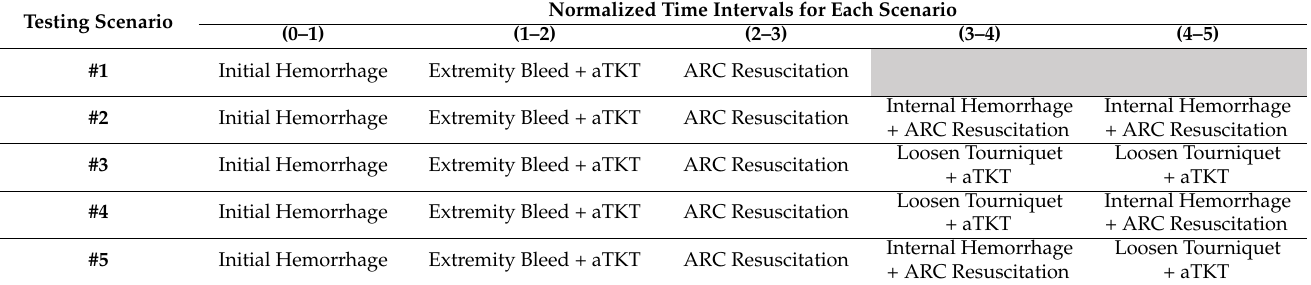
Table 2. Experimental Design for Evaluating SACM. Scenarios or case studies for demonstrating the utility of having SACM controlling multiple autonomous system sub-units. Five scenarios in total were evaluated with different internal or extremity hemorrhages, as shown. Triplicate tests were performed at each